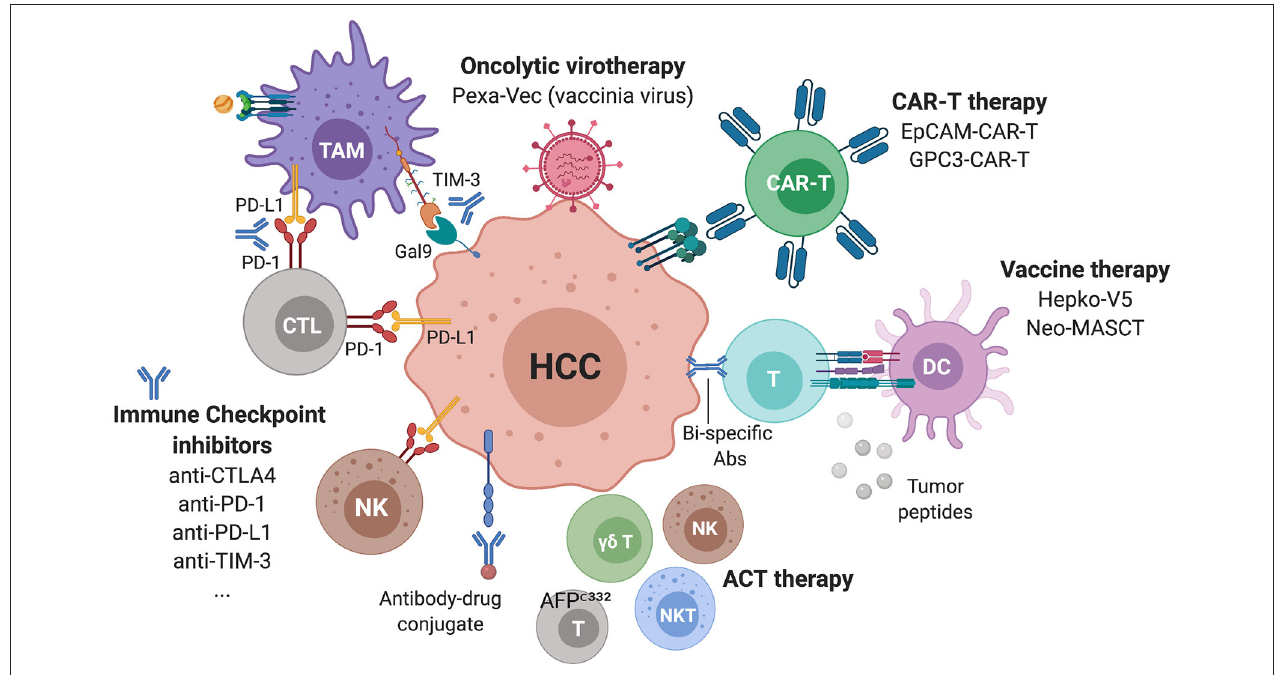
FIGURE 6 | Immunotherapies in ongoing clinical trials for advanced HCC. Several ICIs targeting checkpoints on lymphocytes but also NK and myeloid cells are currently being assessed as monotherapies or in combinations. Additional strategies include CAR-T cells, oncolytic viruses, vaccines, antibody-drug conjugates and bi-specific